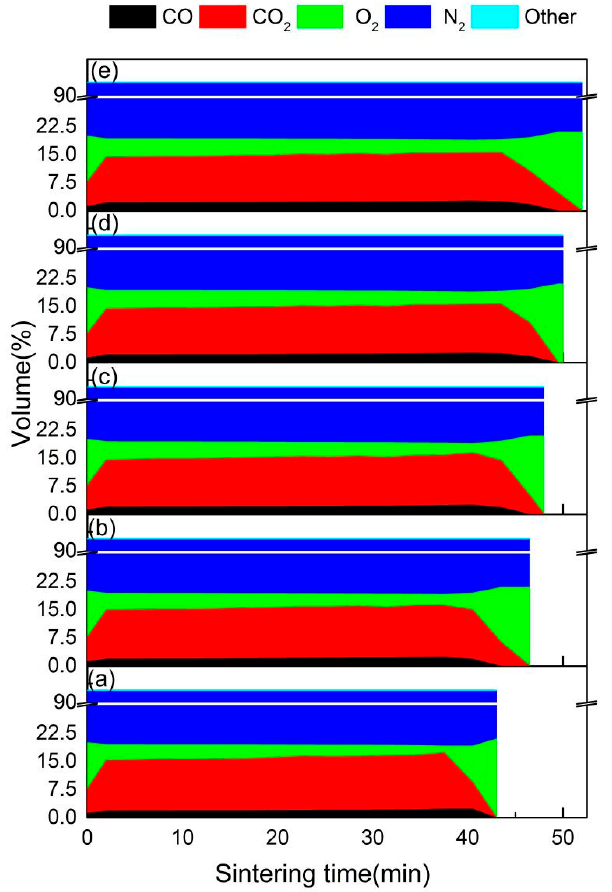
Figure 1. Variation of flue gas during sintering process. ( a ) C = 4.0%; ( b ) C = 4.5%; ( c ) C = 5.0%; ( d ) C = 5.5%; and ( e ) C = 6.0%.